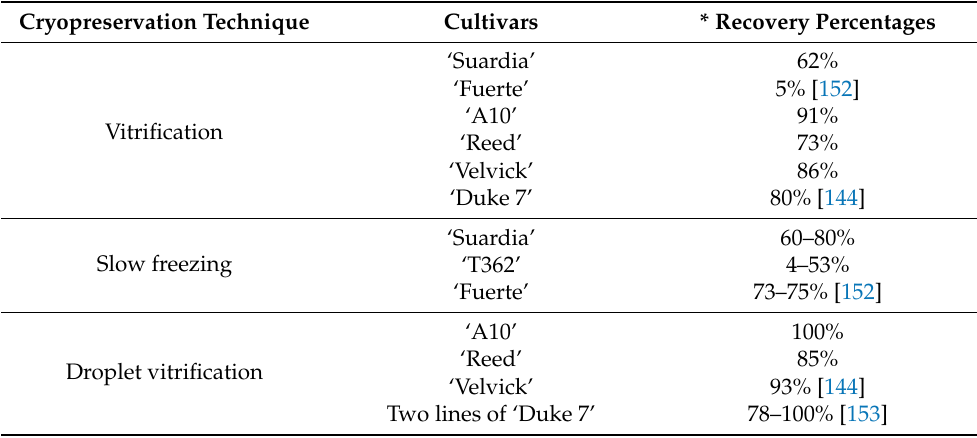
Table 7. Summary of successfully applied cryopreservation techniques to avocado somatic embryos. * Recovery is defined as any somatic embryo clump which was proliferating into new callus clumps. Cryopreservation